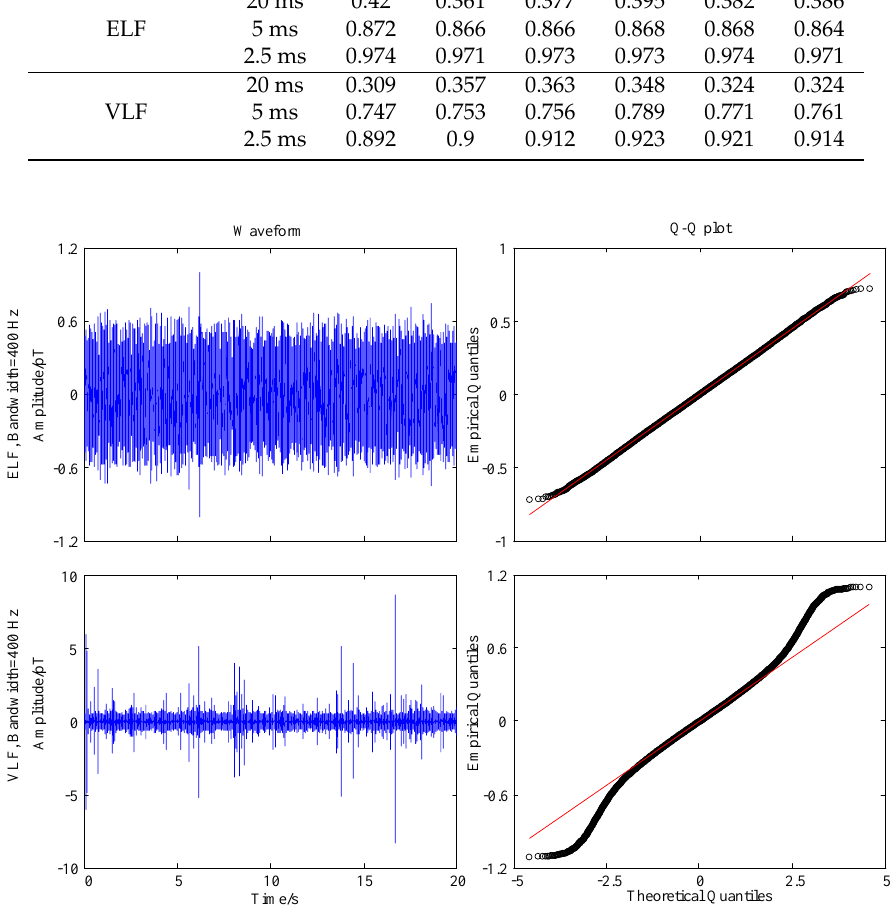
Figure 8. Waveform and the corresponding QQ -plot of the extremely low frequency (ELF) and very low frequency (VLF) noise. QQ-plot is performed for the noise processed by a hole puncher with a threshold of four times standard